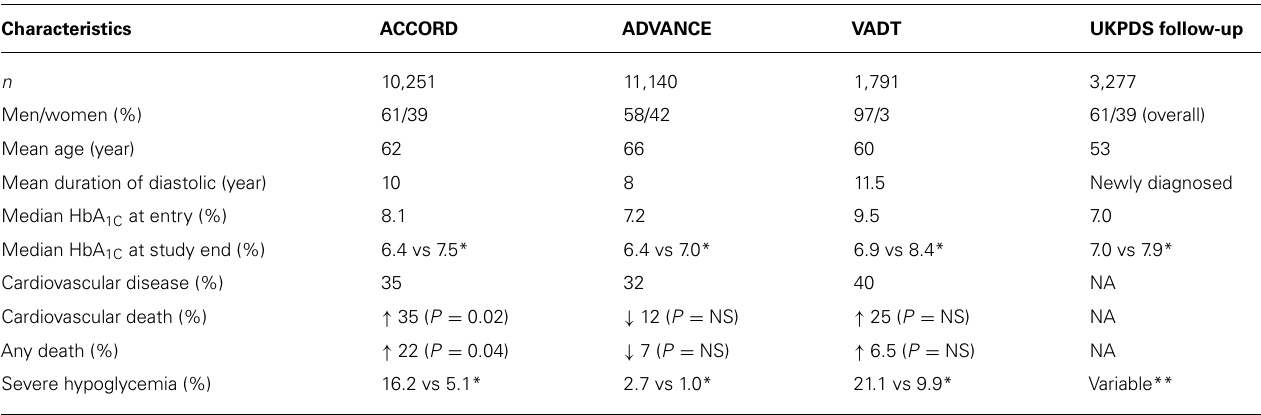
Table 1 | Clinical characteristics and outcomes of intensive glucose lowering vs standard therapy on primary end point and mortality.